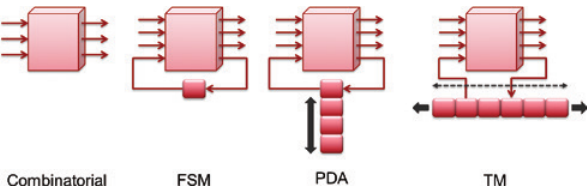
Figure 4: State and various